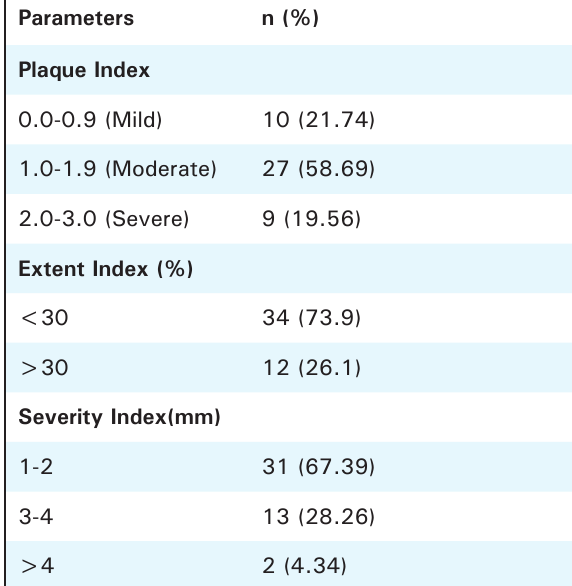
Table 2. Periodontal status of pregnant women.